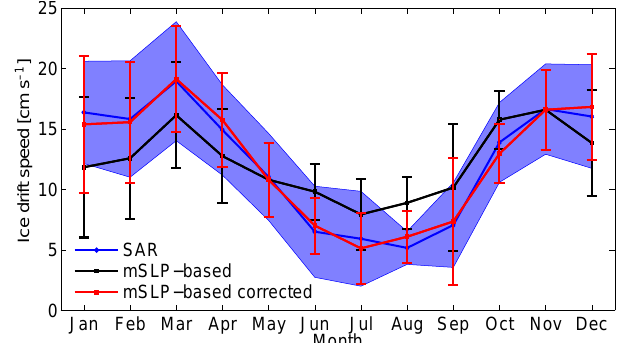
Figure 4. Annual cycle of monthly mean southward ice drift speed in Fram Strait between 2004 and 2014. Observed ice drift speed (SAR) are shown in blue, and our pressure-based ice drift speed in black. The corrected ice drift speed is shown in red. Standard devi- ations of observed ice drift speed are shaded in purple, and those of calculated ice drift speed as vertical colored